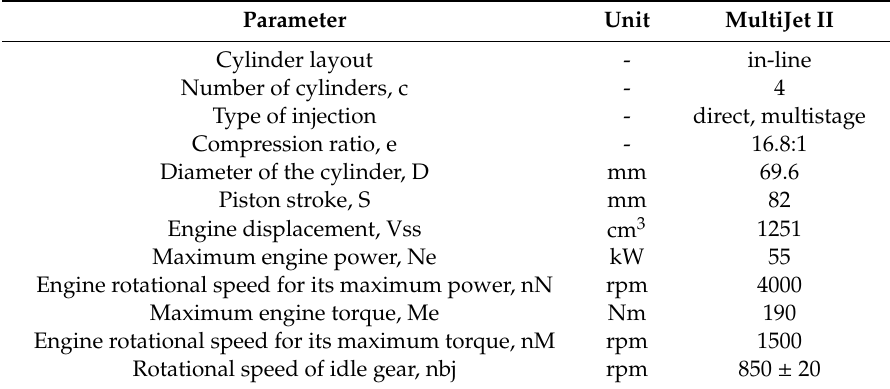
Table 1. Basic technical data of the engine 1.3 MultiJet II used in the